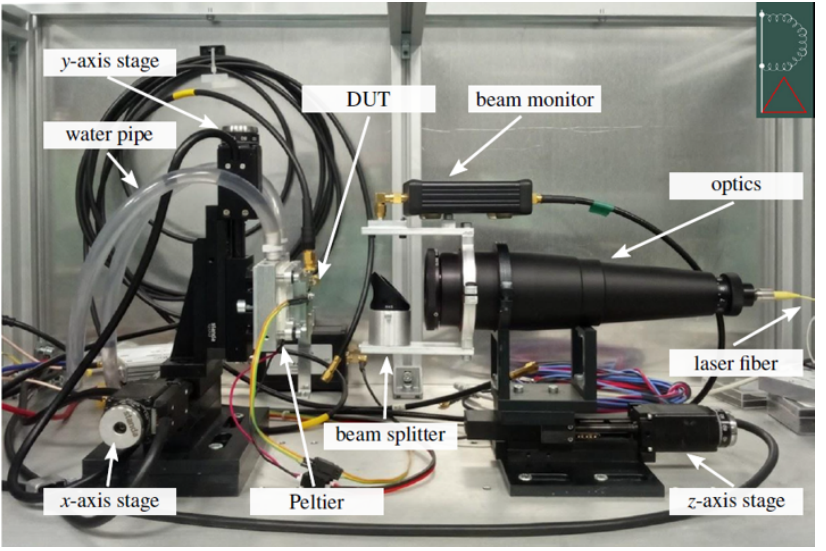
Figure 5. Transient current technique